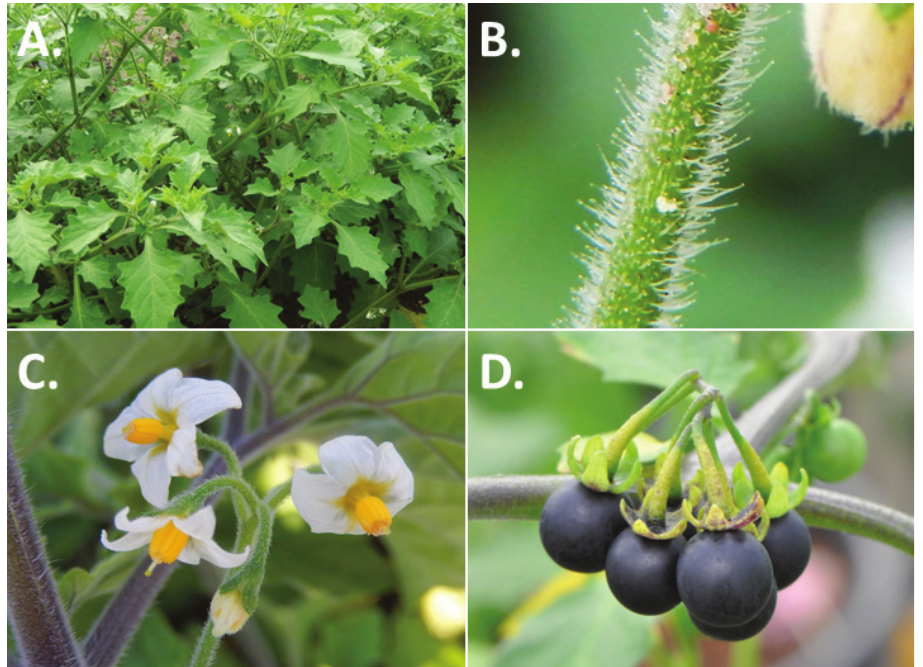
Figure 43. Solanum retroflexum Dunal. A Habit B glandular indumentum present in some individuals C flowers D mature, slightly ellipsoid matte black-purple fruits with reflexed calyx lobes ( A, C Nijmegen acces- sion A1450022 B Nijmegen accession 944750163 C Nijmegen accession A14750023 D Nijmegen acces- sion A14750025). Photos by S. Knapp and G. van der Weerden (previously published in “PhytoKeys